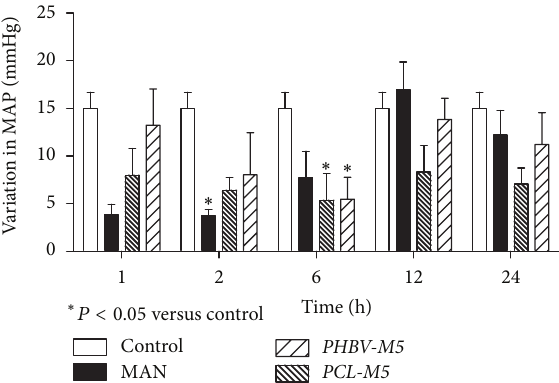
Figure 8: Effects of MAN on mean arterial pressure (MAP) after phenylephrine injection. Formulations PCL-M5 and PHBV-M5 , pure MAN, and water (control group) were administered orally to the animals. Statistical analysis was performed using ANOVA test followed by Dunnet’s post hoc